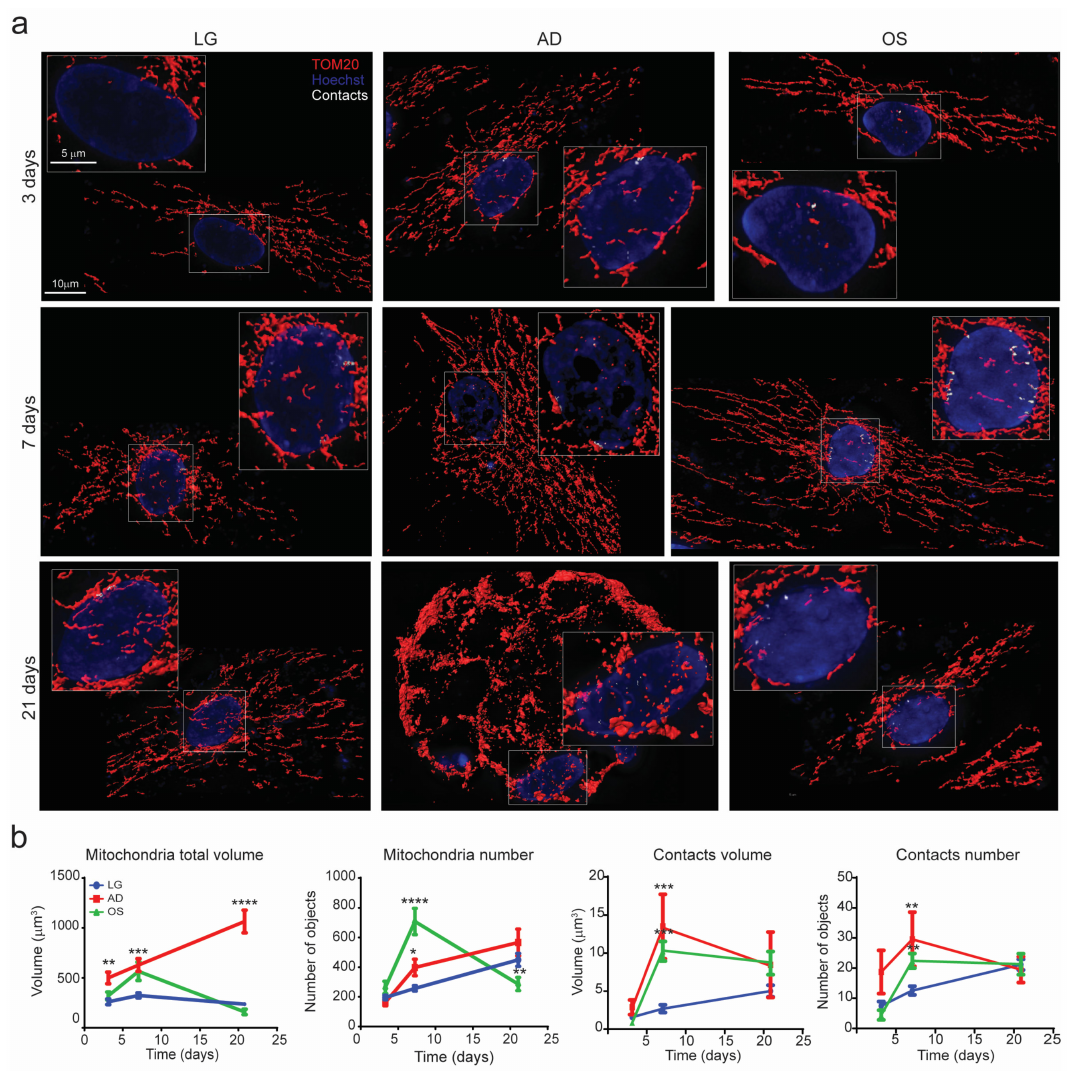
Figure 1. Mitochondria-nucleus contacts. Mesenchymal stem cells (MSCs) were cultured in low-glucose (LG), adipogenic (AD) and osteogenic (OS) media for 3, 7, and 21 days, as indicated. ( a ) Representative 3D images of mitochondrial morphology, as detected by anti-TOM20 Ab immunofluorescence, and contact sites identified by creating the isosurface of the colocalization channel between nuclear staining (Hoechst) and TOM20. Magnification 40x. Scale bar 10 µ m (in zoom panel, scale bar 5 µ m). ( b ) Quantification of mitochondrial total volume, number, and total volume and number of contacts. Data are derived from ≥ 45 acquired cells / condition from ≥ 3 independent experiments. Data are shown as the mean ± SD. ANOVA, * p < 0.1, ** p < 0.01, *** p < 0.001, **** p < 0.0001 with respect to the LG condition at the same time